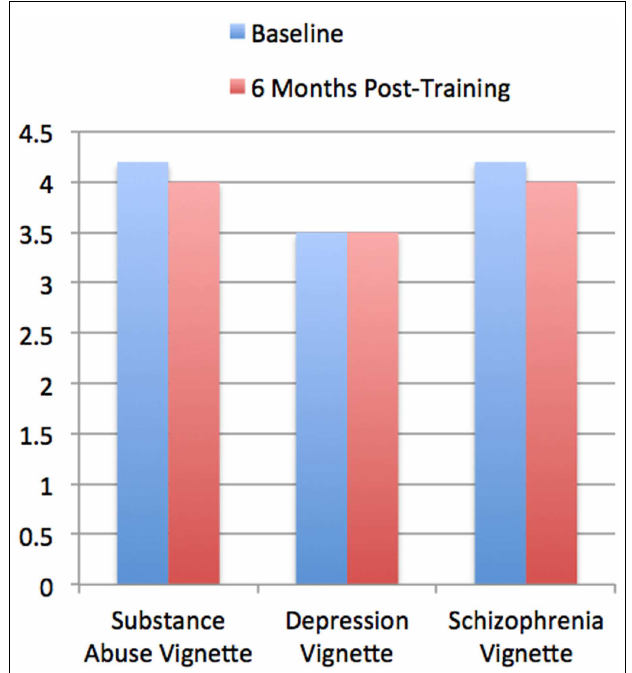
FIGURE 2 | Social Distance Scale (SDS) at Baseline vs. 6months post-training. The version of the SDS used in the present study contained three scripted vignettes about schizophrenia, depression, and substance abuse followed by statements such as “Would you be willing to move next door to John?”The data is from police officers who completed both baseline and 6-month follow-up ratings ( n = 170). Baseline measurements were determined using a five-point Likert scale ranging from “definitely willing” (1) to “definitely unwilling” (5). Higher scores indicate more social distance and lower scores indicate less social distance (range 1–5). Data are shown at “Baseline,” i.e., before police officers were trained, and 6months post-training. Community samples reported in the literature, defined as “controls” from Link et al. (1999), Nordt et al. (2006) are 3.2 (substance abuse), 2.5 (depression), 3 (schizophrenia). It can be seen that the police officers ratings at Baseline appear higher to those of the community Controls, i.e., that there appears to be greater stigma among the police officers compared to community Controls.